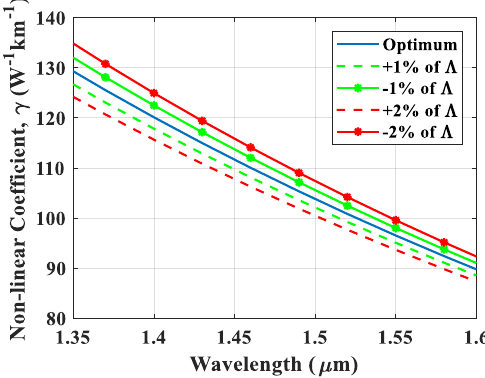
Figure 6. Effect of pitch deviation on nonlinearity.